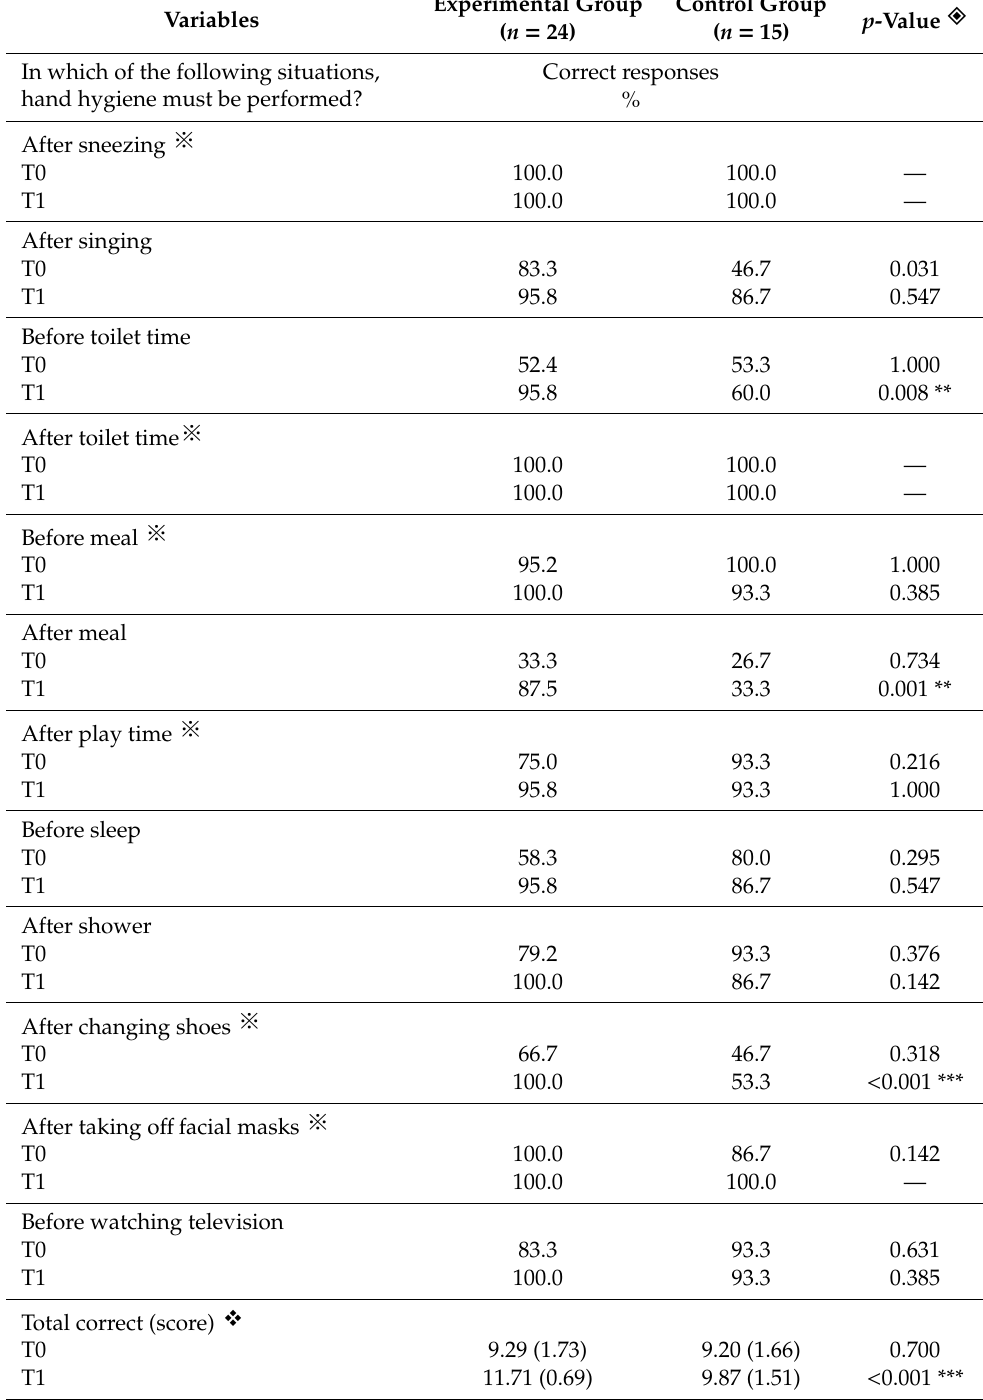
Table 1. Knowledge level between groups towards hand hygiene.